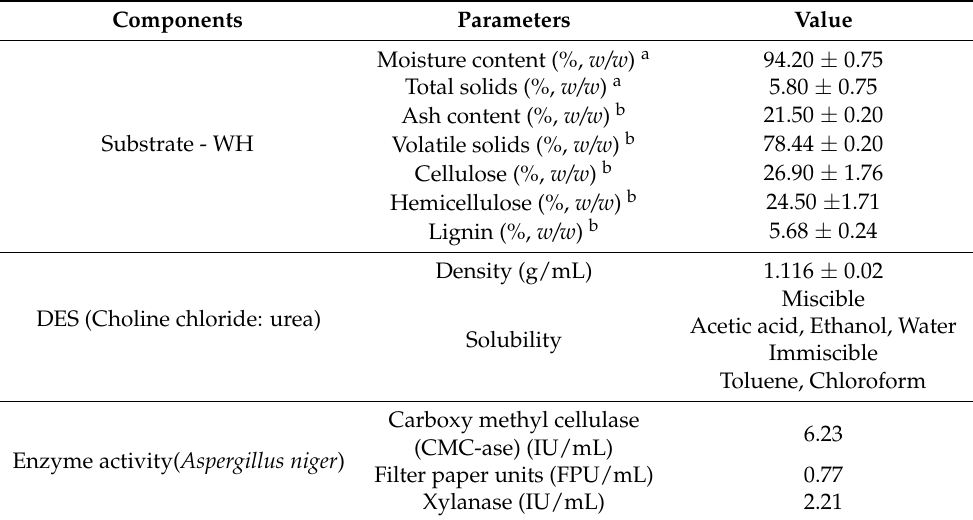
Table 1. Characterization of substrate, DES and enzymes employed in this